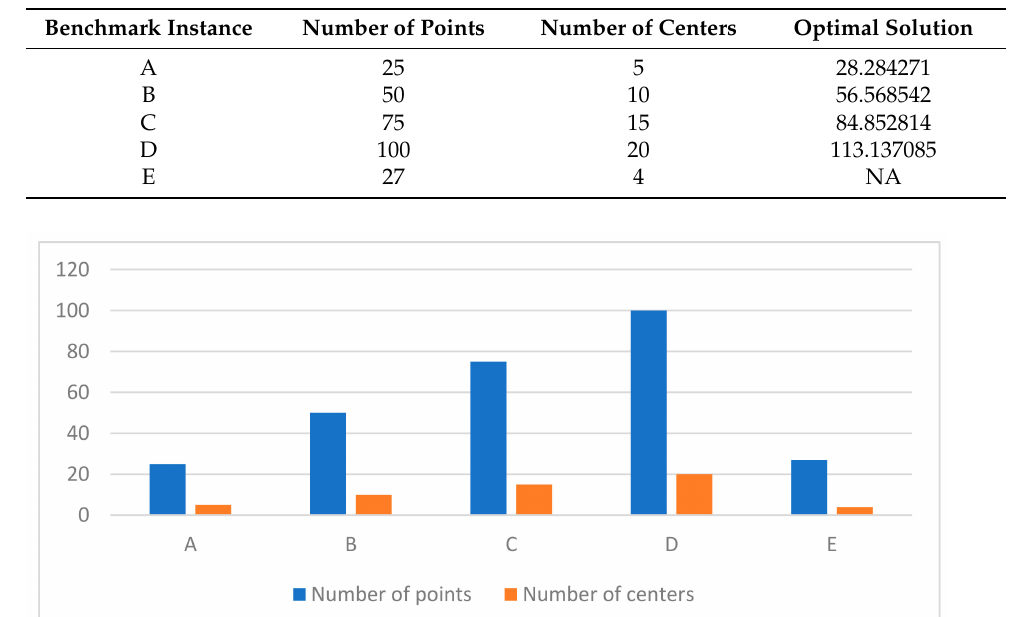
Figure 2. Visualization of benchmark instance E. The basic parameters and the optimal solution (if available) of all the benchmark instances are shown in Table 2 and in Figure 3. Table 2. Benchmark instances.